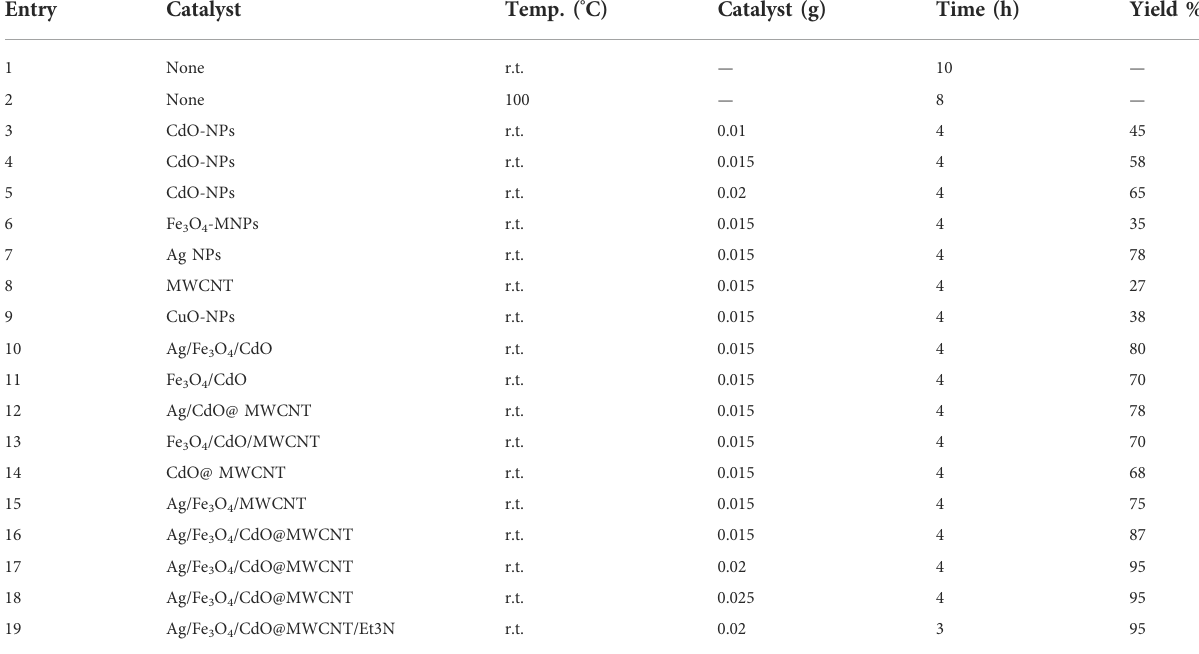
TABLE 1 Determining the most optimal conditions, including catalyst, amount of catalyst, and temperature for the synthesis of 7a.